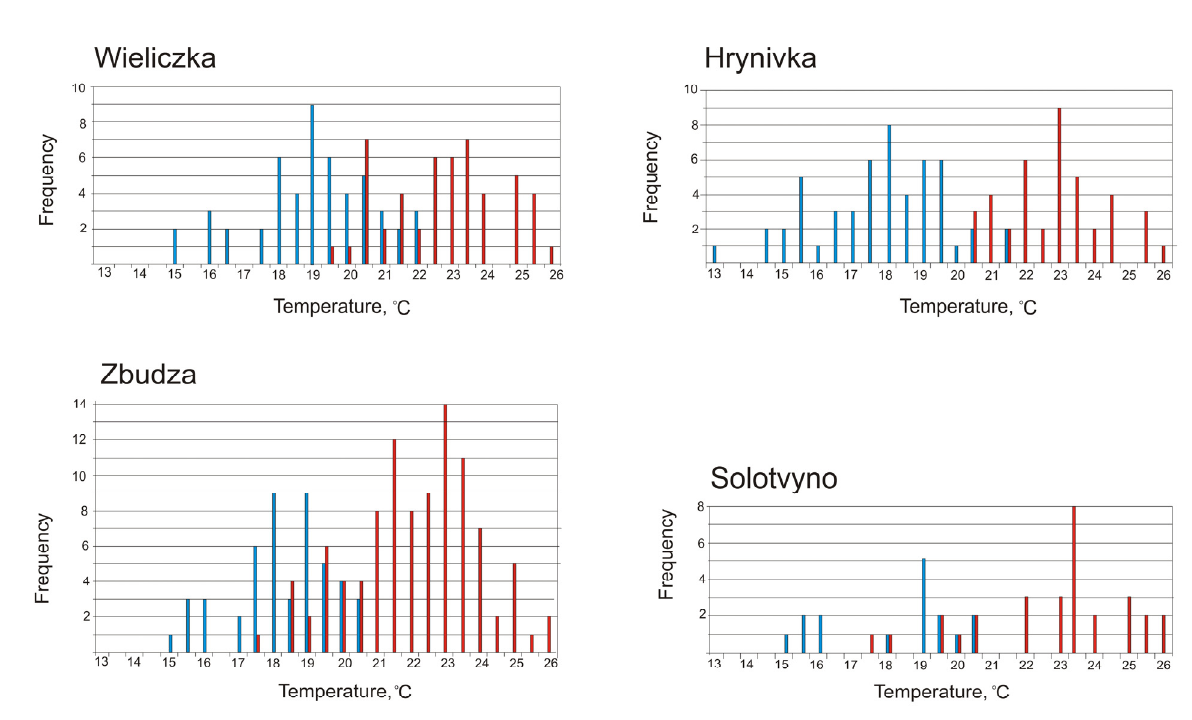
Figure 4. Distribution of the homogenization temperatures of the bottom halite inclusions from Wieliczka Salt Mine, Zbudza, Borehole Ep-2, Hrynivka, Borehole No. 525, and Solotvyno Salt Mine. Colour coding. Blue: temperatures ranging from 13.0 to 22.0 °C in 18 samples. Red: temperatures are ranging from 17.5 to 26.0 °C in 18 samples. The precision of the Th measurement (±0.5 °C).